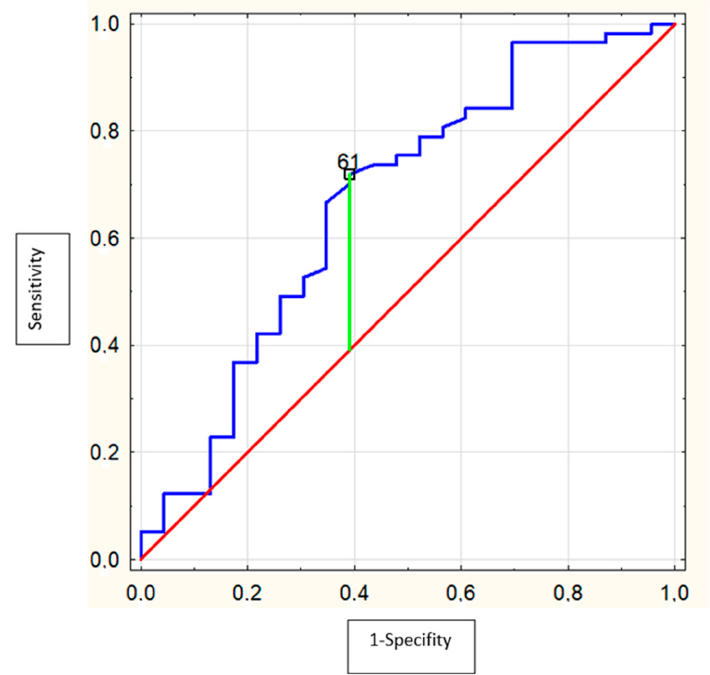
Figure 3. Receiver operating characteristics (ROC) curve of the ability of MMP-9 to differentiate the